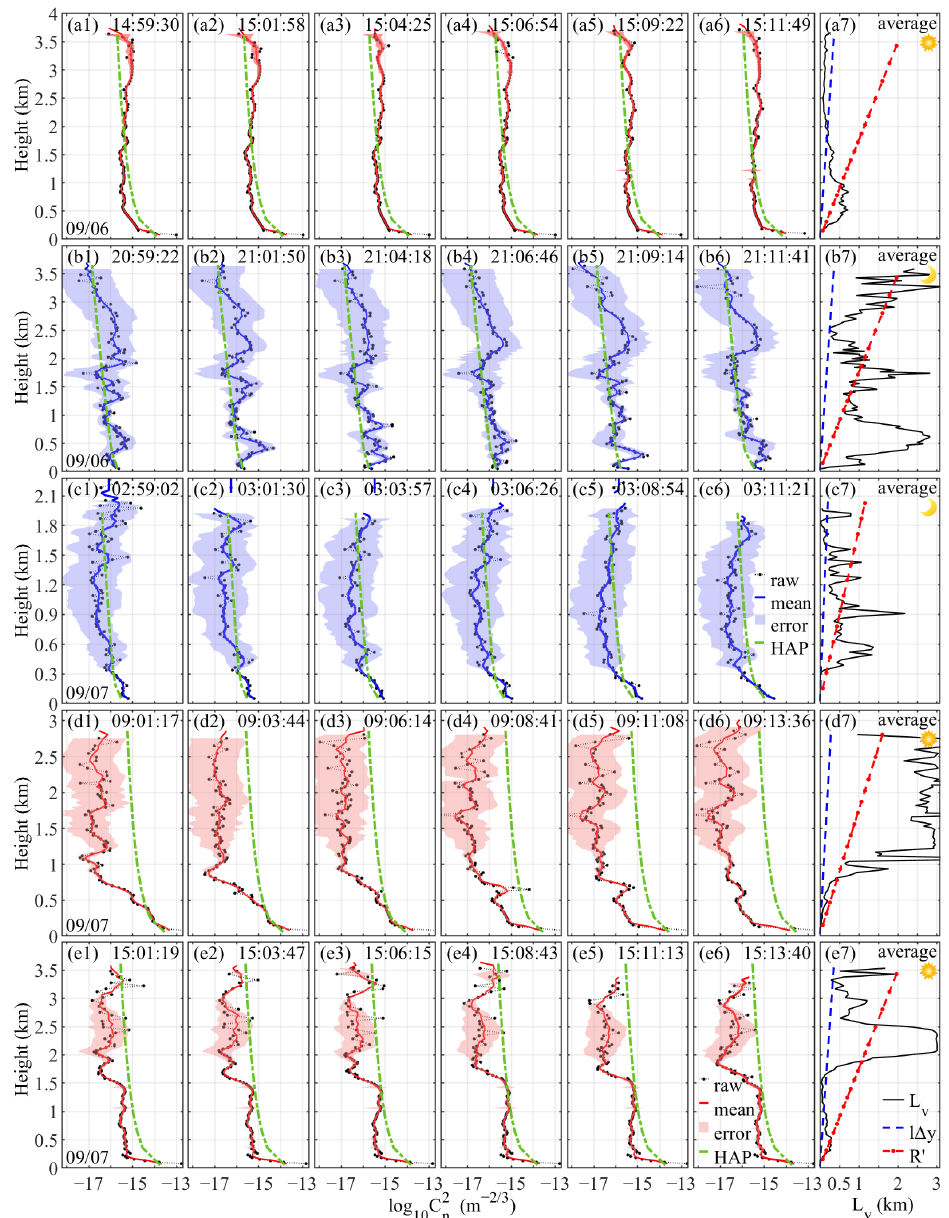
Figure 9. Profiles of log 10 C 2 n in raw data that are distance averaged and show a shaded area error bar, calculated from the HAP model and time averaged integral scale L v ( a7 – e7 ) during the period of 14:59:30–15:11:49 ( a1 – a6 ) and 20:59:22–21:11:41 ( b1 – b6 ) on 6 September and 02:59:02–03:11:21 ( c1 – c6 ), 09:01:17–09:13:36 ( d1 – d6 ), and 15:01:19–15:13:40 ( e1 – e6 ) on 7 September 2019, local time.